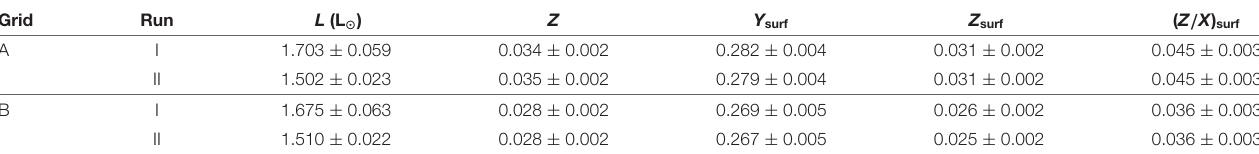
TABLE 4 | Luminosities and abundances determined using different grids and observational constraints. Grid